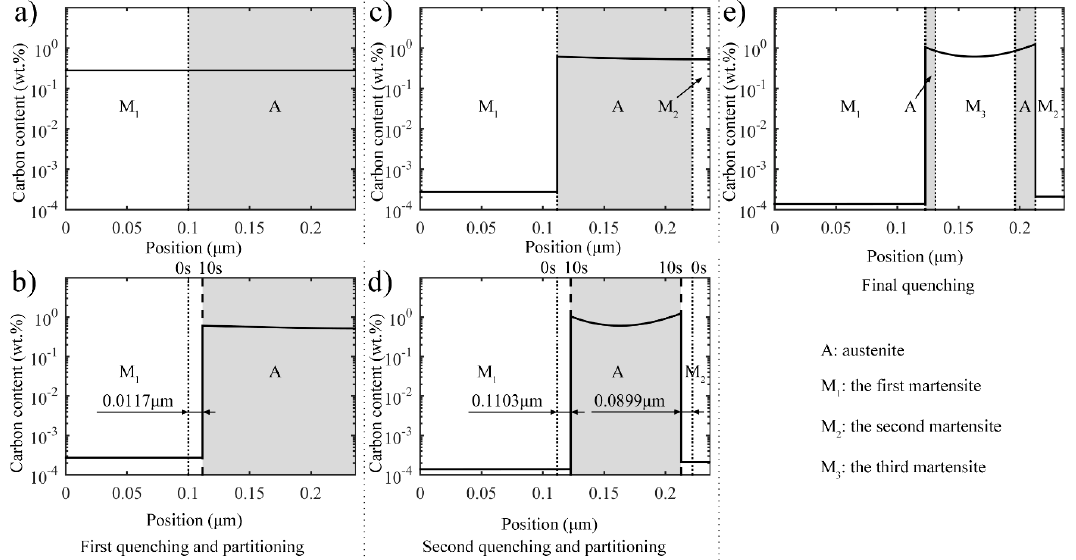
Figure 1. Schematic diagrams of the ( a ) two-stage and ( b ) one-stage Q-P processes.